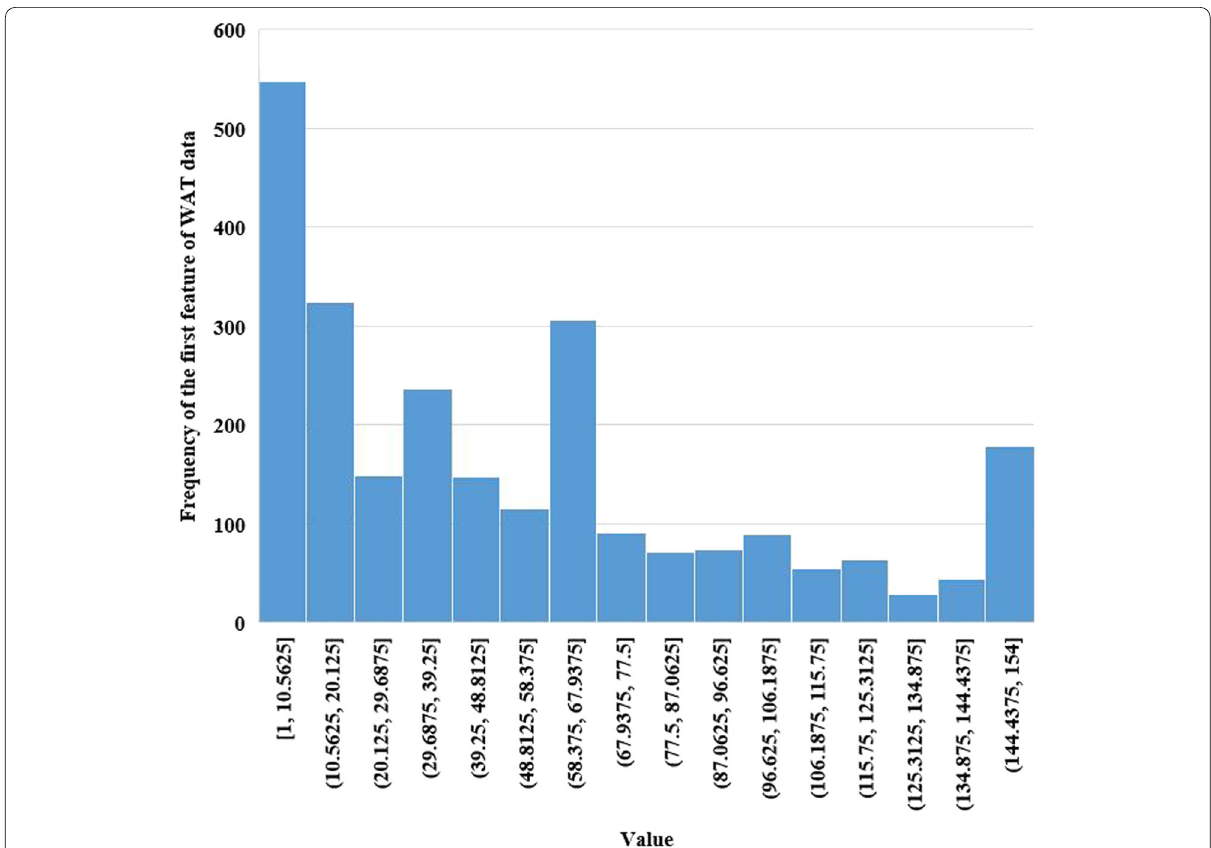
Figure 6 Data distribution of the first feature of WAT data after tailing operation